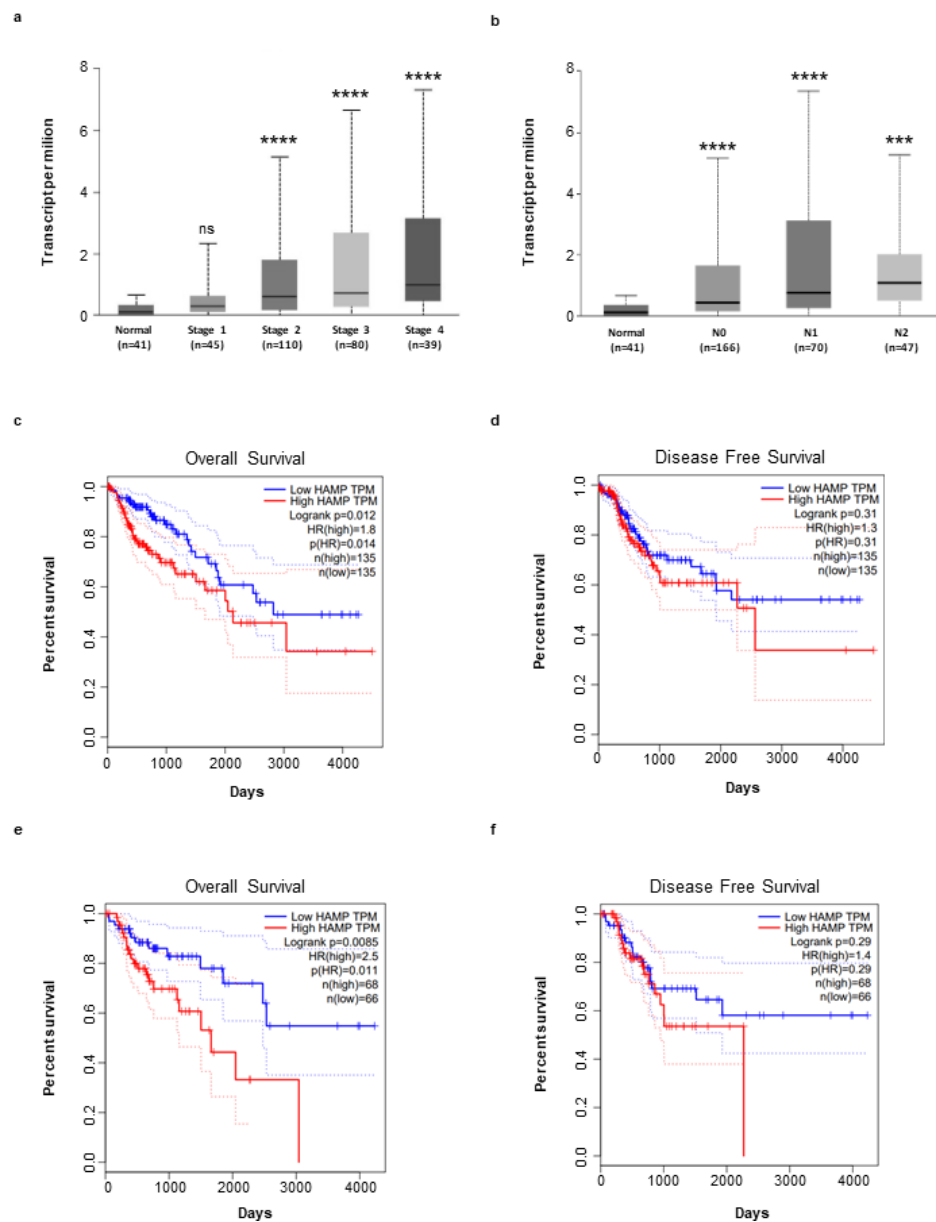
Figure 6. Hepcidin expression is correlated to CRC progression and affects survival of patients. ( a , b ) Increase in hepcidin RNA expression in different groups of CRC based on tumor stage ( a ), [Normal ( n = 41) versus CRC Stage 1 ( n = 45), ns (ns, not statistical significant); Normal ( n = 41) versus CRC Stage 2 ( n = 110), **** p < 0.0001; Normal ( n = 41) versus Stage 3 ( n = 80), **** p < 0.0001; Normal ( n = 41) versus Stage 4 ( n = 39), **** p < 0.0001] and lymph node metastases ( b ) [Normal ( n = 41) versus N0 ( n = 166), **** p < 0.0001; Normal ( n = 41) versus N1 ( n = 70), **** p <